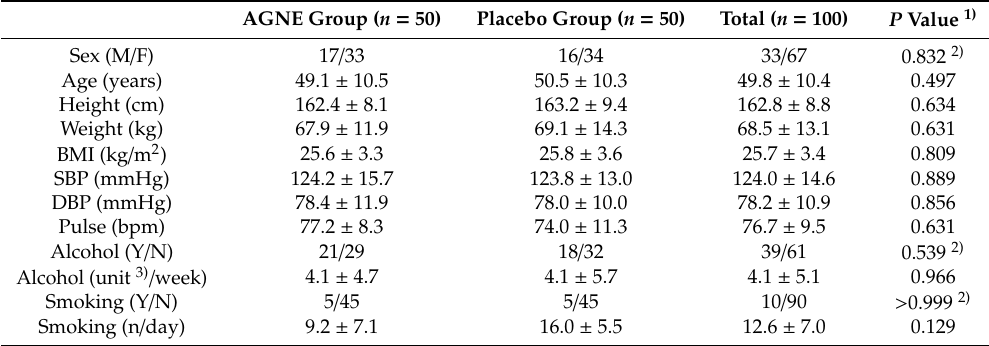
Table 2. Baseline general characteristics of the subjects.